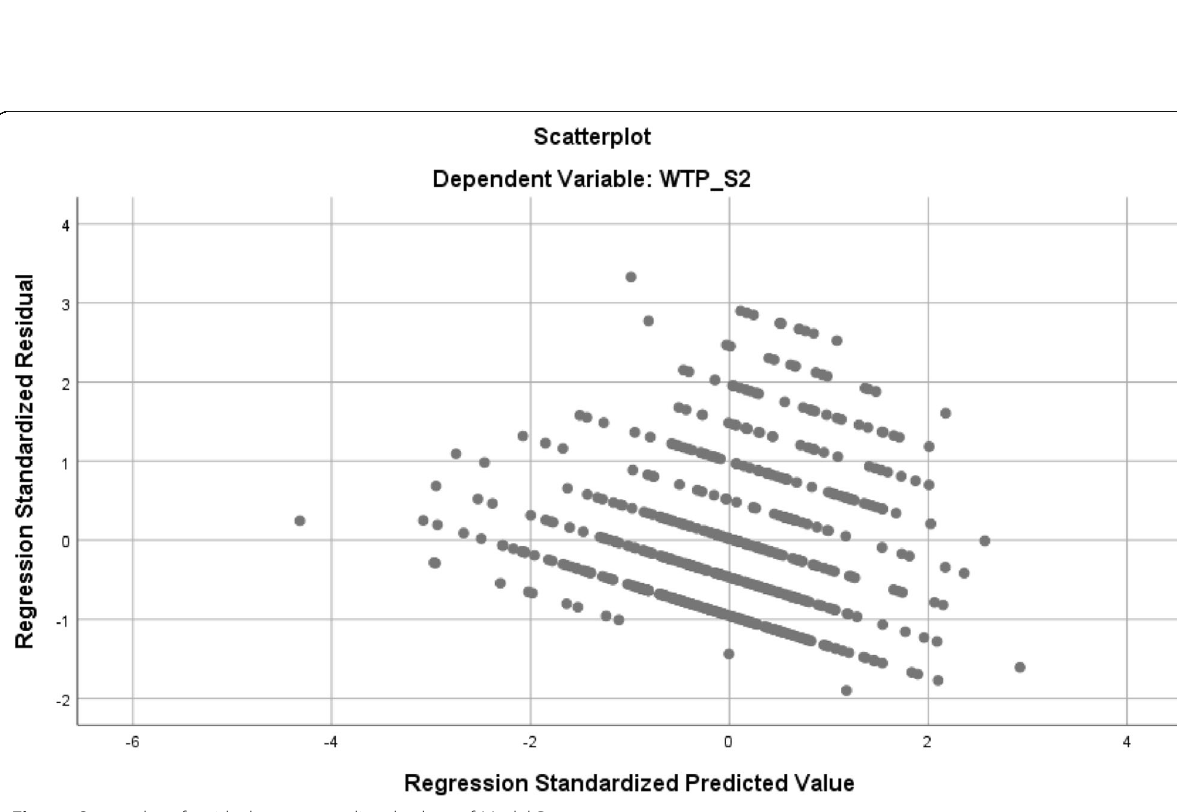
Fig. 14 Scatterplot of residuals versus predicted values of Model